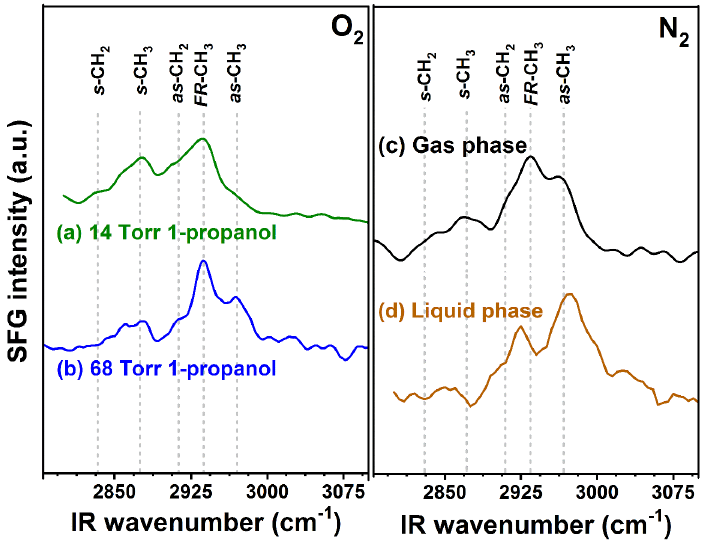
Figure 6. SFG spectra collected for gas phase 1-PrOH on Pt thin film during reactions at 60 °C with 101.33 kPa of O 2 : ( a ) 1.87 kPa (14 Torr) of 1-PrOH; ( b ) 9.07 kPa (68 Torr) of 1-PrOH. SFG spectra collected for 1-PrOH on Pt thin film at 60 °C purged with N 2 : ( c ) gas phase, 10.67 kPa of 1-PrOH; ( d ) liquid phase 1-PrOH. (SFG data for 1-PrOH oxidation were reported in [21]. Reproduced with permission from [21]. Copyright 2018 American Chemical Society.).